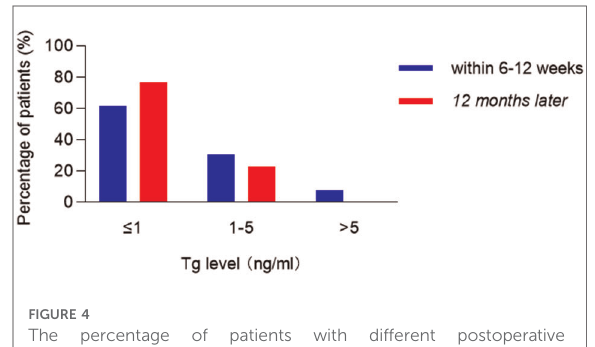
FIGURE 4 The percentage of patients with different postoperative thyroglobulin